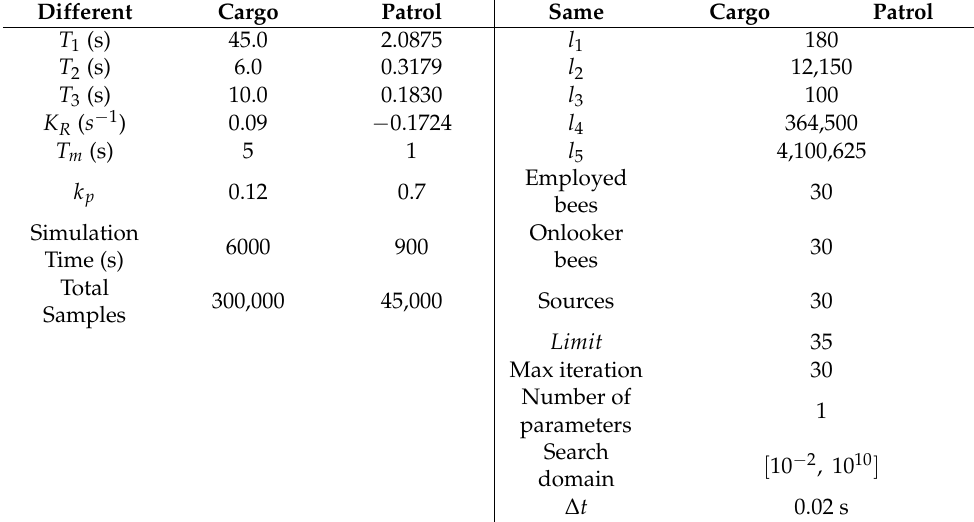
Table 3. Settings of the experimental